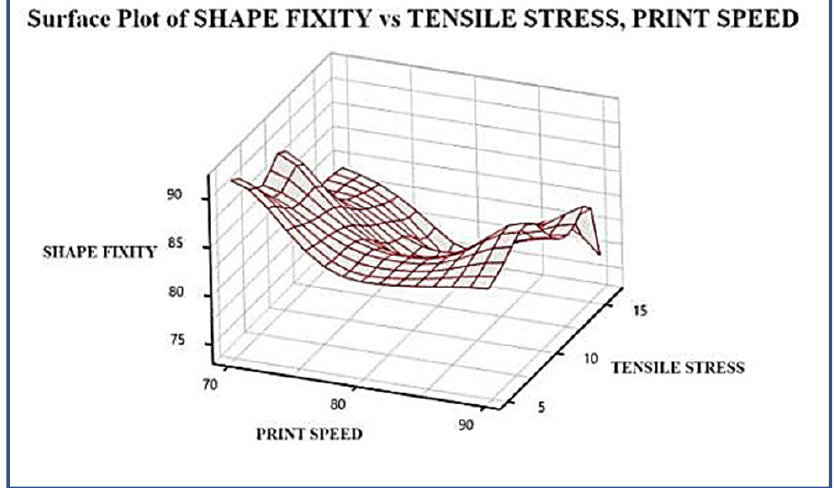
Figure 10. Variation of Shape fixity with changes in Tensile Stress and print speed.